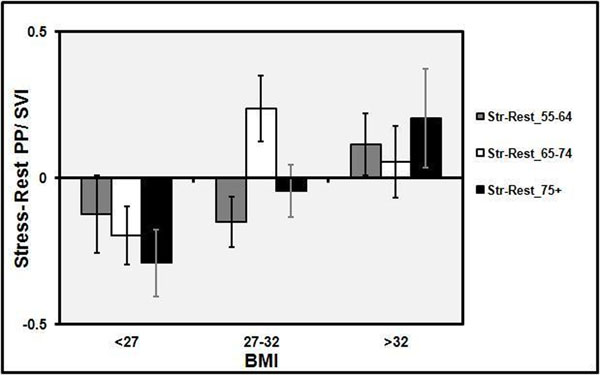
Change in PP/SVI: Stress- Rest